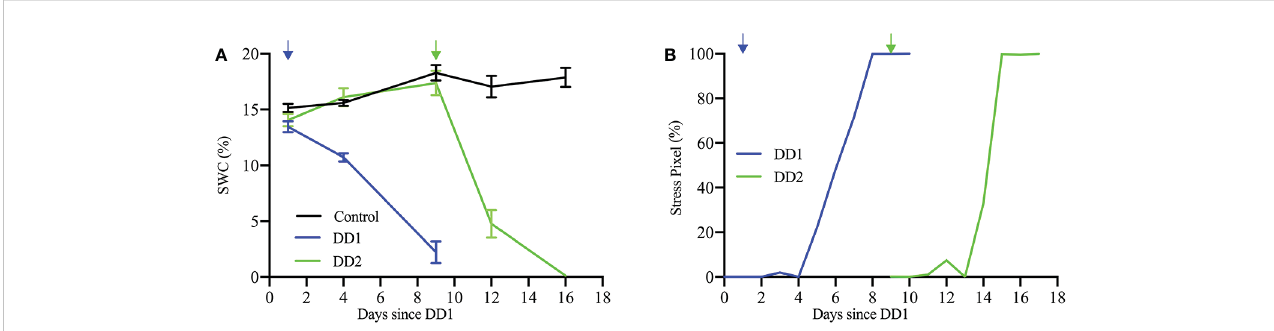
FIGURE 14 (A) SWC (%) for the control and the two dry-down groups (DD1, Plant ID: 613-200-20 and DD2, Plant ID: 613-195-15); and (B) stress pixel (%) over days since DD1 for the same